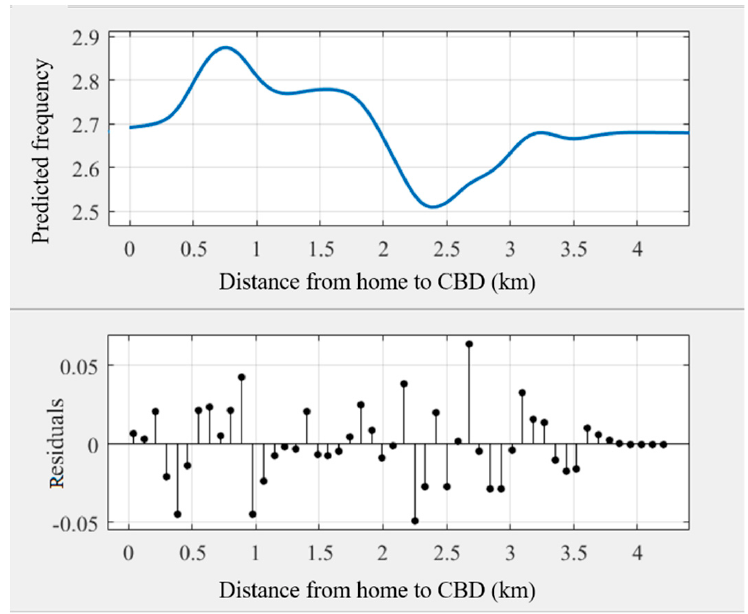
Figure 8. Nonlinear associations between the distance from home to the CBD (CBDDIST) and cycling frequency among older adults.